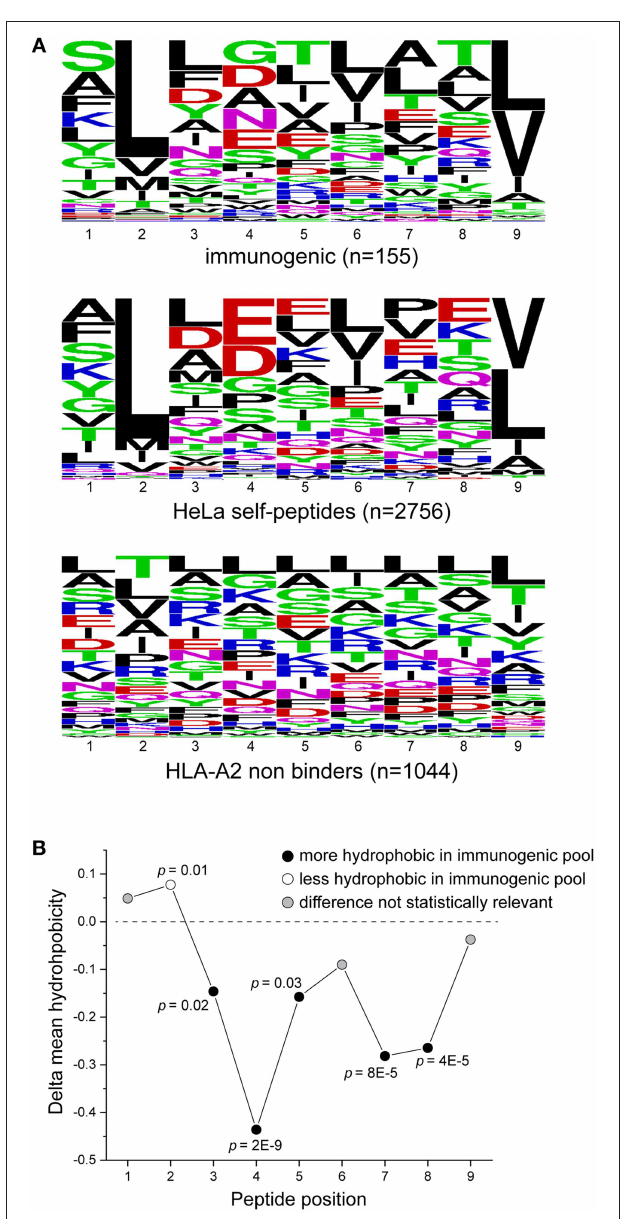
FIGURE 3 | Characteristics of peptides in the training set. (A) Sequence logos of immunogenic peptides (top), HeLa self-peptides (middle), and HLA-A2 non-binding peptides (bottom). (B) Comparison of the hydrophobicity of each peptide position in the immunogenic and self-peptide datasets (shown as the difference between the immunogenic and self-peptide datasets) as determined using the Wimley-White hydropathy index. Values less than zero (below dashed line) indicate greater hydrophobicity in the immunogenic dataset. P -values are indicated where the differences are statistically